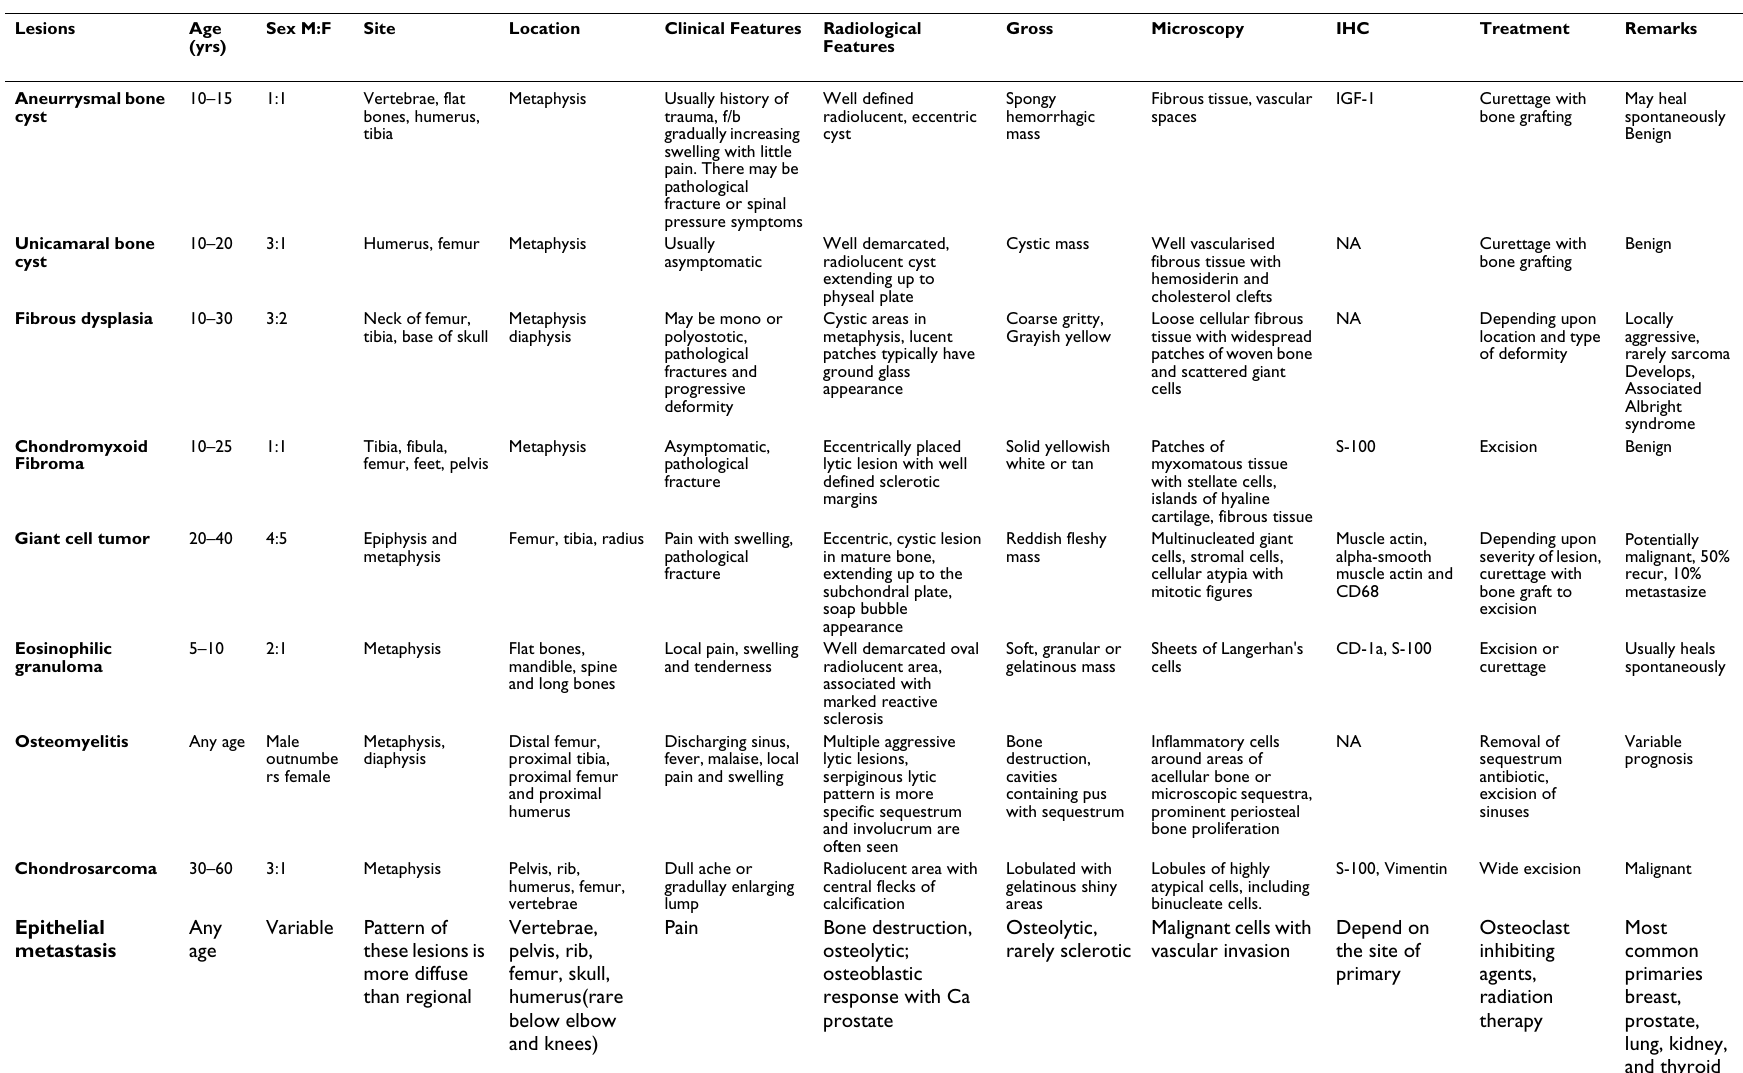
Table 6: Differential diagnosis of Adamantinoma